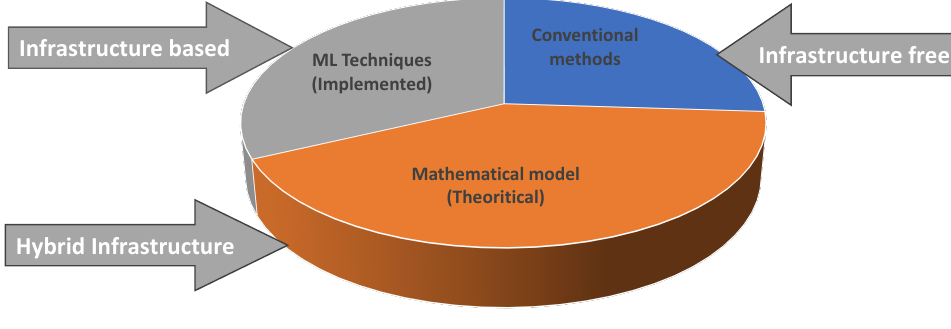
Figure 3. Distribution of TDE